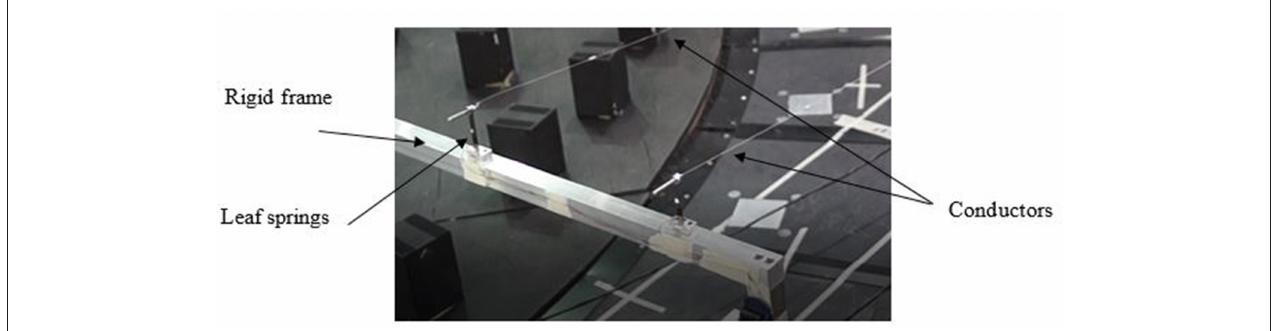
FIGURE 5 | Leaf spring instrumentation at cable ends.